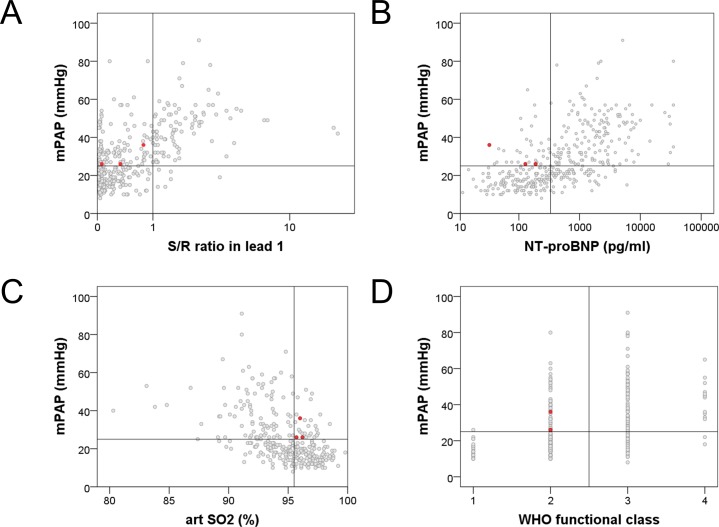
A-D. Associations between the simple non-invasive parameters and mean pulmonary arterial pressure–data based on the analysis of the retrospective cohort. The three red dots represent the patients with pulmonary hypertension who were missed by the algorithm. (mPAP: mean pulmonary arterial pressure, NTproBNP: N-terminal pro brain natriuretic peptide, art SO2: arterial oxygen saturation).